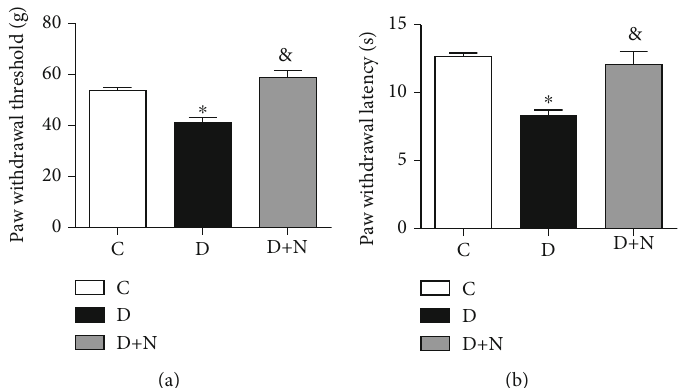
Figure 3: Variations of (a) PWT and (b) PWL during the progression of STZ-induced diabetes (D) and treated with N-acetylcysteine (D+N) in rats. All results are presented as means ± SD , n = 6 /group; ∗ P < 0 : 05 (D vs. C), & P < 0 : 05 (D+N vs.